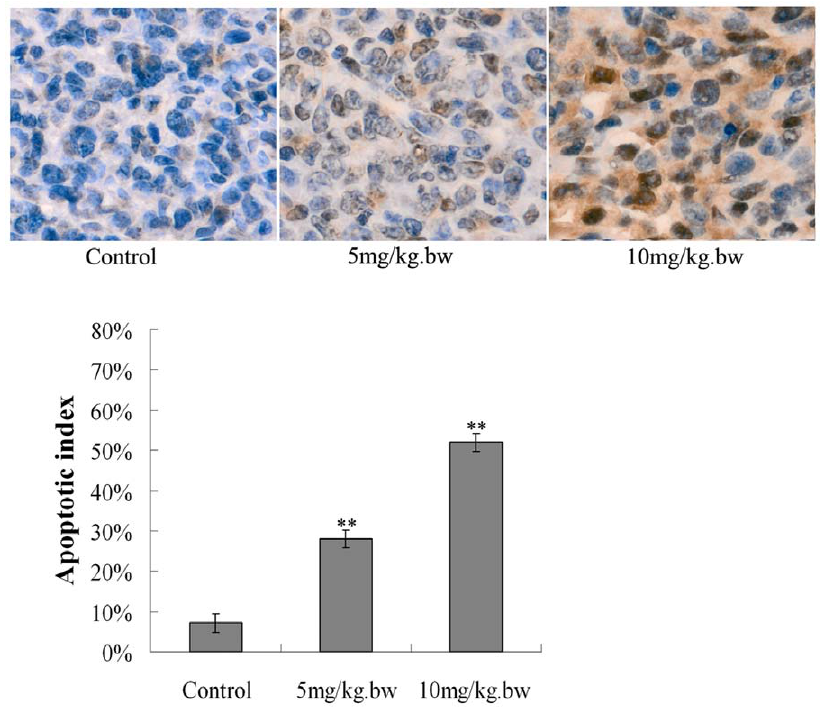
Figure 6. Fucoidan induced apoptosis in vivo. Representative photographs of the tumor sections examined by TUNEL assay. TUNEL-positive cell nuclei (dark brown) were observed under a fluorescence microscope ( 6 400). The number of apoptotic cells was counted 5 random fields ( 6 400) in a blinded manner. Each bar represents the ‘‘apoptosis index’’, expressed as mean 6 SD. Fucoidan treatment caused a significantly higher percentage of TUNEL-positive apoptotic cells. ** P , 0.01 vs Control.